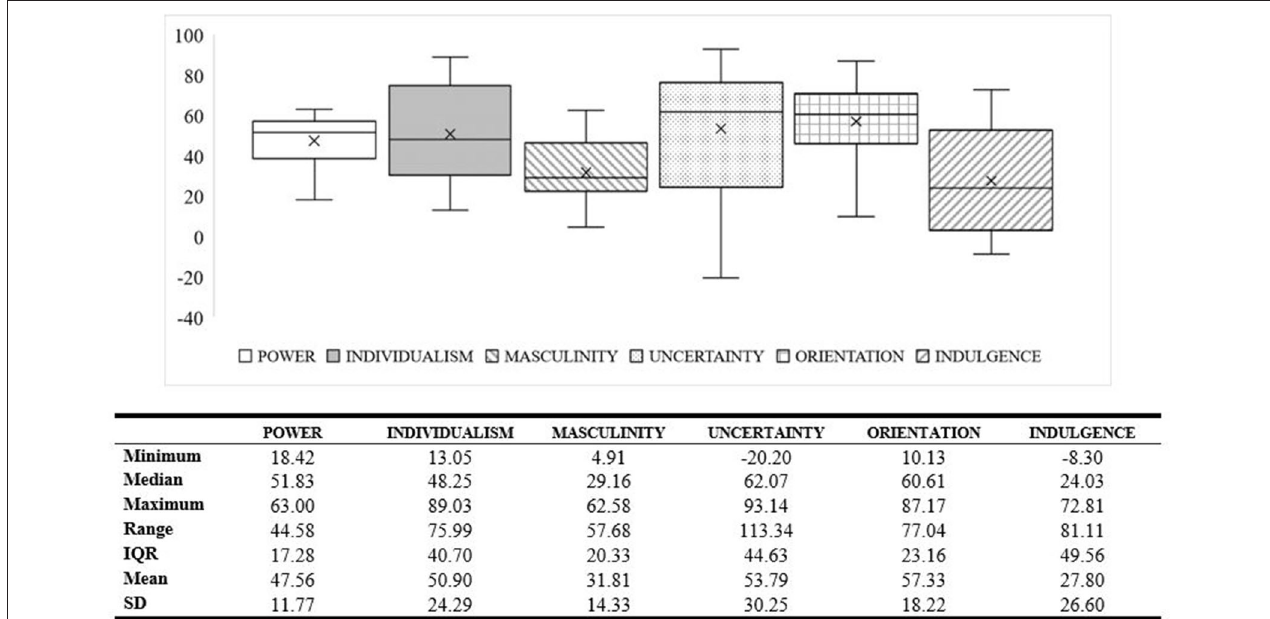
FIGURE 1 | Distribution of country-by-gender scores in each